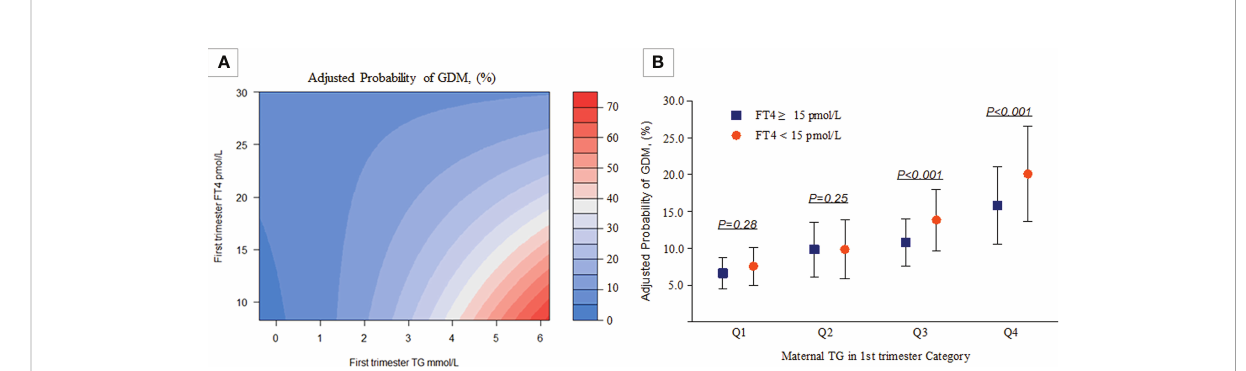
FIGURE 3 Combined effect of maternal FT4 status and maternal TG categories in early pregnancy on the proportion of women diagnosed with GDM. (A) A heatmap for the association of GDM (red colour indicates a higher probability of GDM, blue colour indicates a lower probability of GDM according to the TG-FT4 interaction ( P for interaction=0.036). (B) The y-axis presents adjusted probabilities and 95% CIs of GDM in different TG and FT4 categories (Q1: P =0.28, Q2: P =0.25, Q3 & Q4: P <0.001). All analyses were estimated from a logistic regression model with adjustment for the previously mentioned covariables.